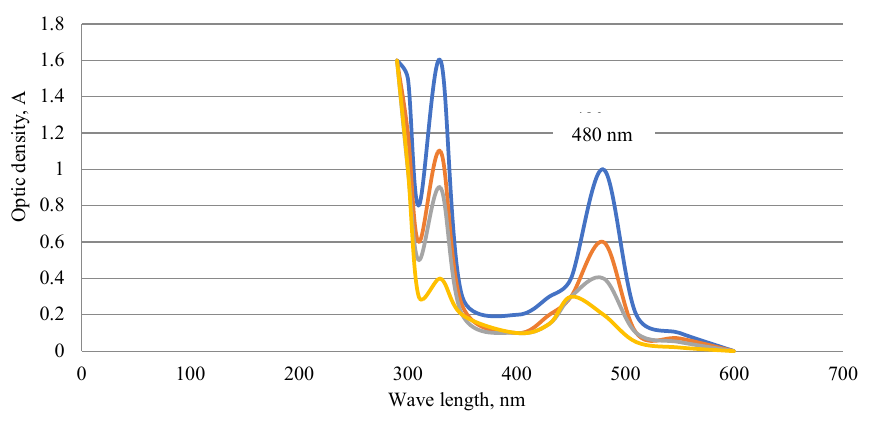
Fig. 2. Phenol’s electronic absorption